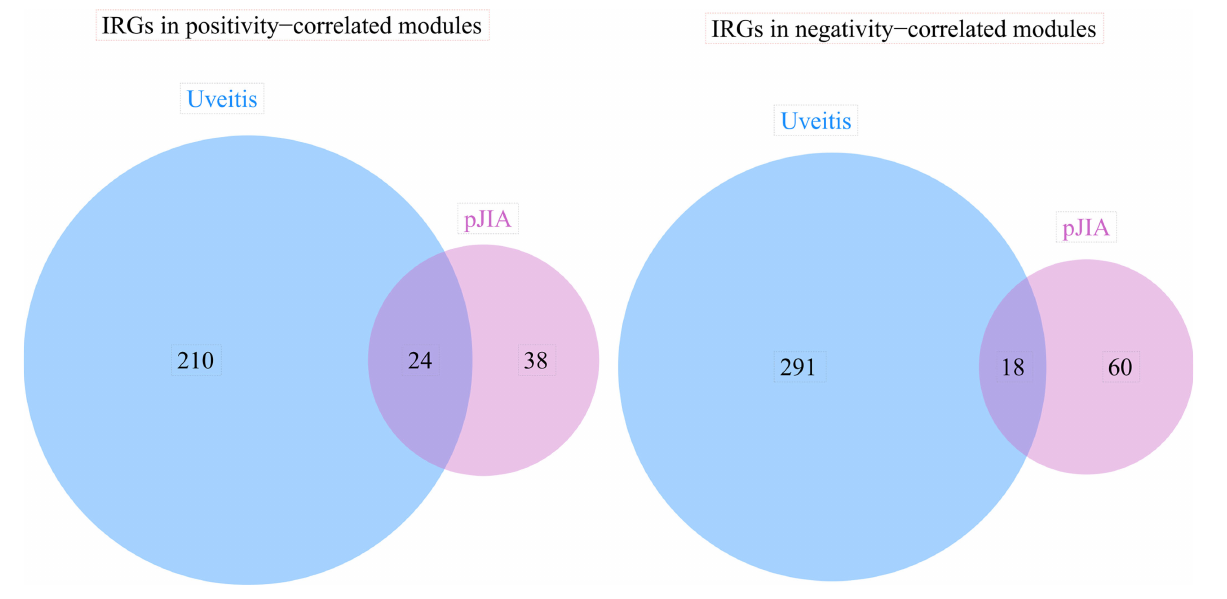
FIGURE 4 The immune-related genes found correlated with pJIA and uveitis. Shared IRGs in positivity-correlated modules: IGF2R, GRN, ZYX, PLCG2, CYBB, IL4R, TYK2, CD4, IKBKG, ADAR, SYK, TPM2, CMTM7, AHNAK, SEMA4D, INPP5D, ZC3HAV1, CMTM3, VIPR1, PSME3, PSMD2, ACVR1B, ACO1, TGFB1. Shared IRGs in negatively-correlated modules: KIR2DL1, KIR2DL4, NCR3, NENF, KIR3DL1, CXCR6, KIR2DL5A, CACYBP, KIR3DL3, IL22, PDGFD, NCR1, PAEP, GHRHR, RORA, PDGFB, JAG2, IL17C.